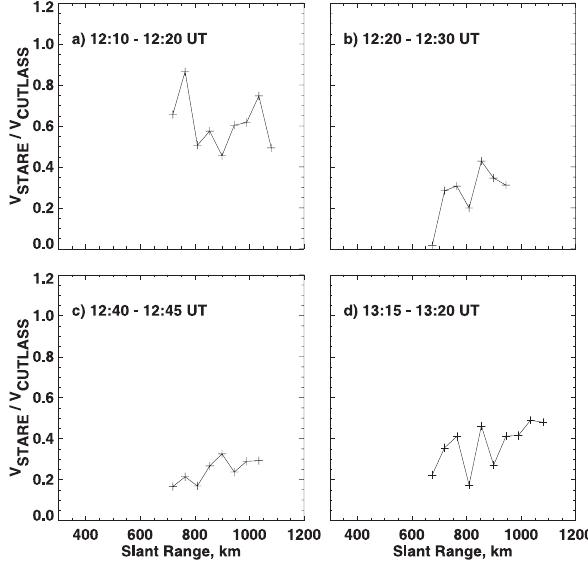
Fig. 9. Range profiles of the velocity ratio R = V STARE /V CUTLASS for several periods of